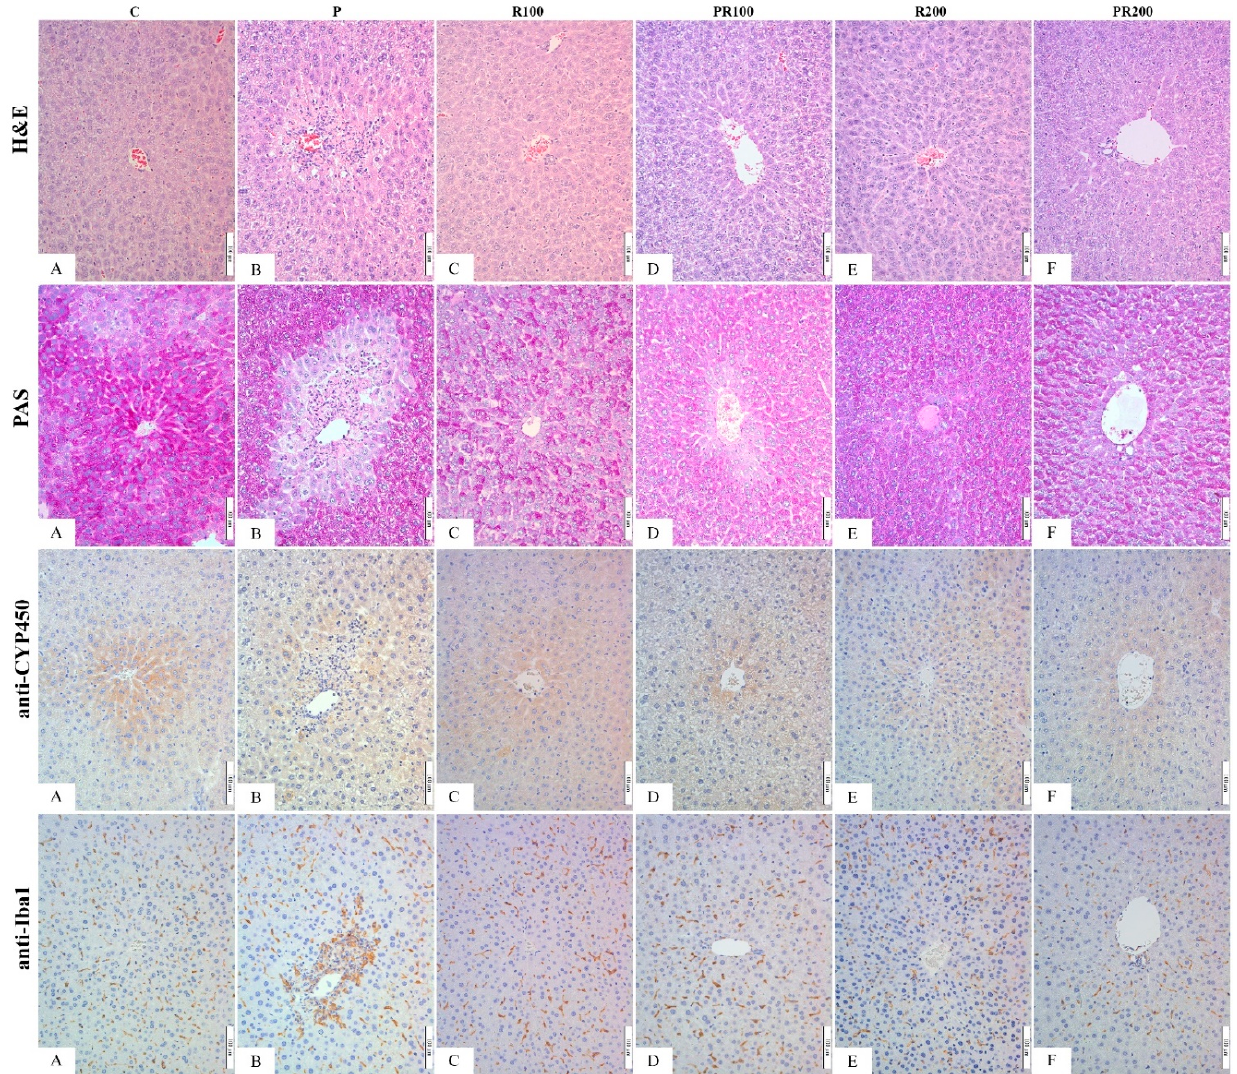
Figure 4. Histological and immunohistochemical analysis of liver tissue of healthy animals and animals with paracetamol-induced liver injury (40 × , H&E—hematoxylin and eosin; PAS—Periodic acid-Schiff; anti-CYP450—monoclonal antibody, clone 2E1; anti-Iba1—monoclonal antibody). Leg- end: H&E —( A ) normal liver histology of ConS group animals; ( B ) centrolobular necrosis and inflammatory infiltrate in ConP animals; ( C ) normal liver histology in CE100 animals; ( D ) moderate to mild parenchymatous degeneration in CE100+P animals; ( E ) unchanged liver histology in CE200 animals; ( F ) almost annulled paracetamol-induced changes (rare, solitary swollen hepatocytes) of CE200+P animals: PAS —( A ) even distribution of glycogen in ConS group; ( B ) central depletion of glycogen in ConP group; ( C ) even, diffuse disptribution of glycogen of CE100 group; ( D ) mild centolobular depletion of glycogen in CE100+P group; ( E ) regular, diffuse glycogen distribution in CE200 group; ( F ) glycogen present in the level of the ConS group in CE200+P group. anti-CYP450 — ( A ) smaller fraction of positive cells in cenrolobular areas of ConS group; ( B ) increased population of positive cells diffuselly trough lobule in ConP; ( C ) CE100 group has rare, centrolobular positive cells similar to ConS; ( D ) CE100+P showing centrilobular and periportal positive cells, but less than ConP; ( E ) rare, mildly positive, diffuse cells in CE200; ( F ) CE200+P showing rare centrilobular and periportal positive cells, less than ConP. anti-Iba1 —( A ) diffuse, solitary postive cells in ConS; ( B ) predominantly centrolobular positivity in ConP; ( C ) diffuse, solitary moderatelly postive cells in CE100; ( D ) diffuse, solitary strongly postive cells in CE100+P; ( E ) rare, diffuse, solitary mildly postive cells in CE200 ( F ) diffuse, solitary strongly postive cells in CE200+P.